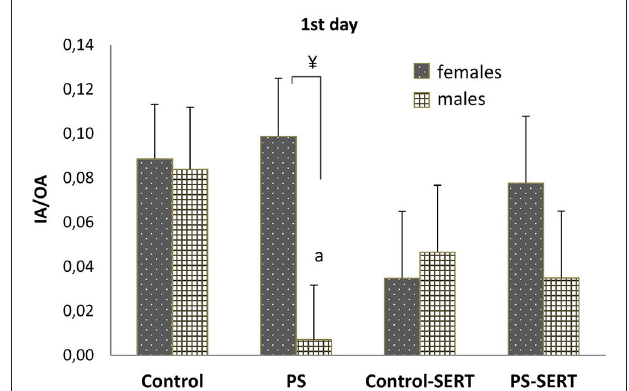
FIGURE 7 | Ratio between inner exploratory activity and outer exploratory activity (IA/OA) on the 1st day of the OF test . a, p < 0.05 indicates a main effect of prenatal stress in males; (cid:85) , p < 0.05 indicates a main effect of sex.